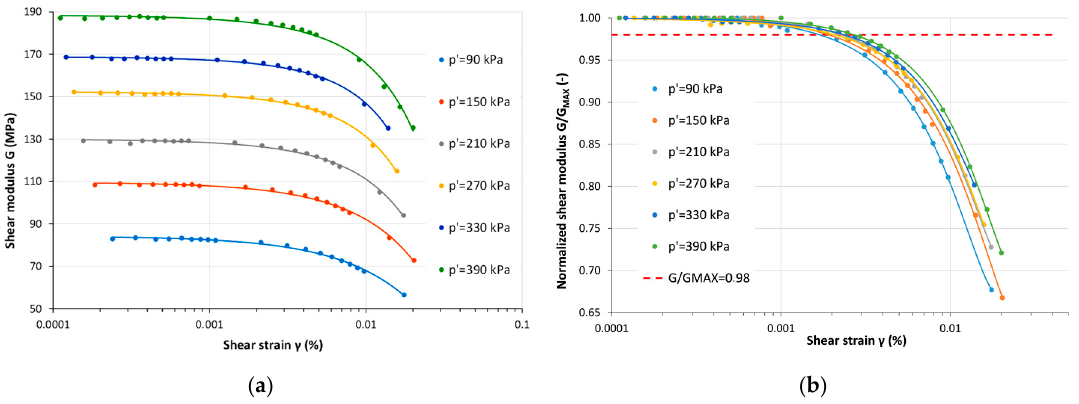
Figure 6. The example of ( a ) shear modulus ( G ) degradation curves and ( b ) normalized shear modulus degradation curves ( G/G MAX ) at various mean effective stress ( p’ ) for specimen 9.